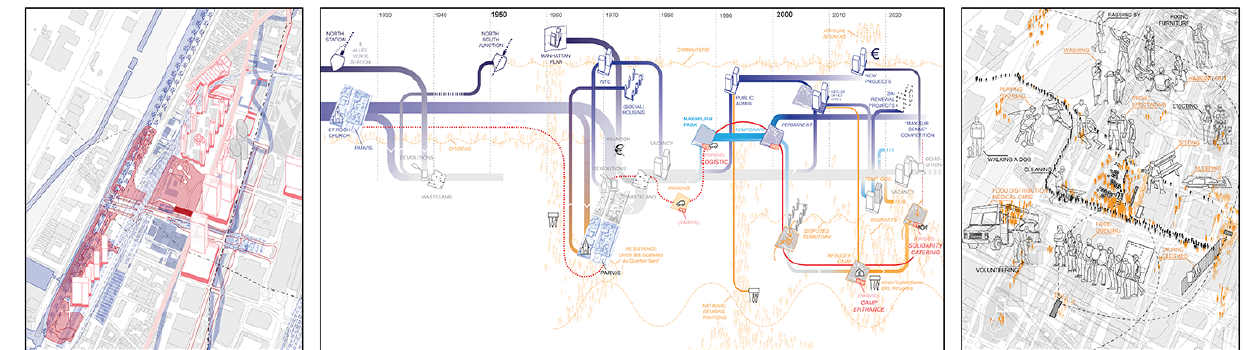
Figure 5. The North Quarter’s palimpsest as a multi-scalar triptych. are spaces where futures are imagined, projected, and tested. These spaces become spatial resignifications be- ing performed and therefore implicitly brought to real- ity by a long list of local stakeholders and everyday life. Tirelessly reiterated and continuously adjusted, resigni- fications transform local meanings and lived realities, in turn leaving marks in the local fabric and in local mem- ory. Resignifications of traces can also be collaborative productions between different levels of power, includ- ing real estate developers and institutions, as the explo- sion of temporary occupation attests. However, in the shadow of the radical transformations that architecture and urbanism tend to project on vacant land, traces are implicit and almost self-reproducing. Seemingly, resignifi- cations are not only waiting for architects to realize